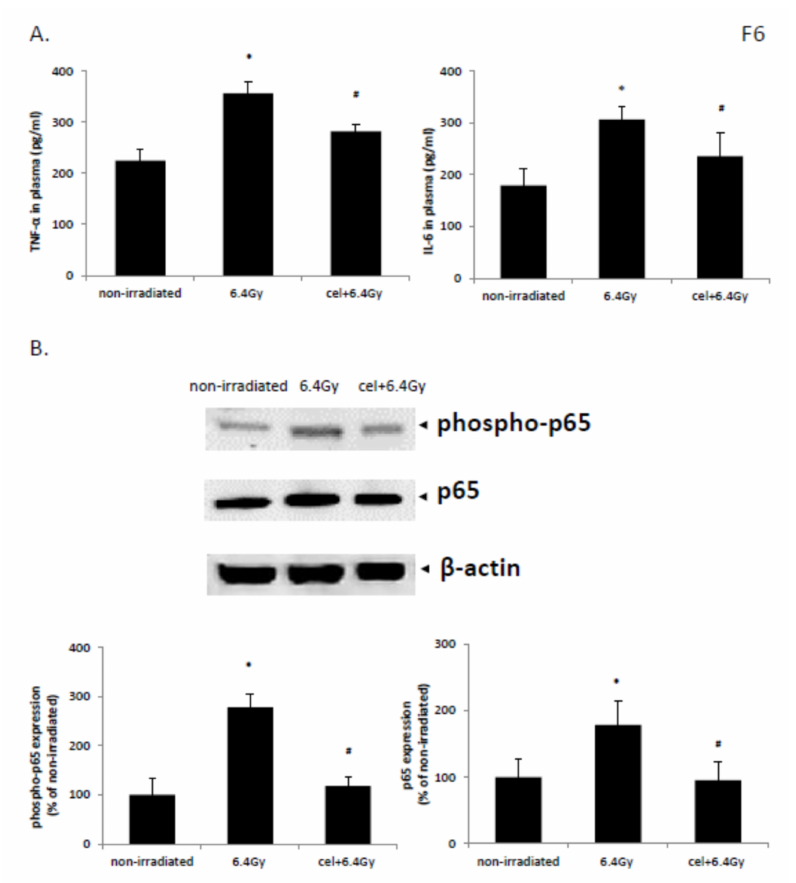
Figure 6. E ff ects of celastrol treatment on the expression of inflammatory cytokines ( A ) and NF- κ B activation ( B ). Nonirradiated control mice received the ip injection of 0.1% DMSO for 30 days without exposure to gamma irradiation. Both 6.4 Gy and cel + 6.4 Gy were subjected to gamma irradiation with 6.4 Gy at day 1, followed by ip injection of 0.1% DMSO or celastrol at 0.25 mg / kg bw for 30 days respectively. ( A ) The expression levels of inflammatory cytokines TNF- α and IL-6 in plasma were evaluated by ELISA ( n = 3 for 6.4 Gy group and n = 5 for other groups). ( B ) Protein expressions of p65, phospho-p65, and β -actin were evaluated by Western blot analysis in the colon tissue of mice. The results were calculated and expressed as fold change relative to control ( n = 3). Data are expressed as mean ± S.E.M. Comparisons between groups were analyzed by One-Way ANOVA followed